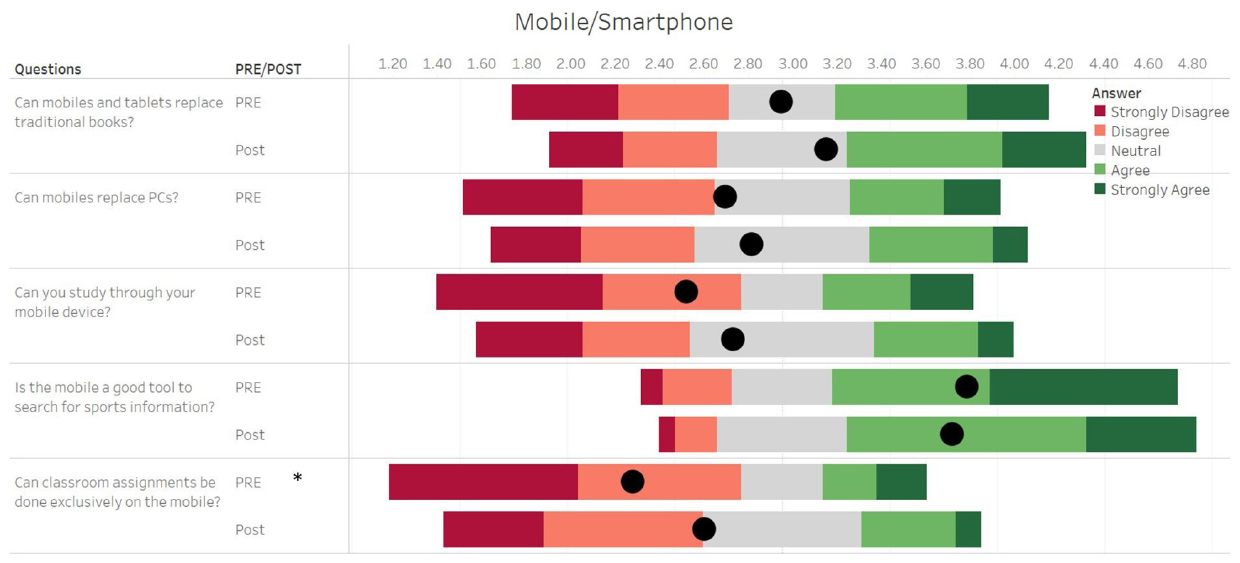
FIGURE 3 | Student responses for questions in the survey related to smartphone usage. The length of each bar of the Gantt chart represents the number of corresponding responses before (PRE) and after (Post) activity, with the black dot representing the average of all values. The responses were recorded on a five-point Likert-type scale, where 1 represented a strong disagreement with the question and 5 represented a complete agreement to the question. * Represents a significant difference between pre- and post-values at p < 0.05.